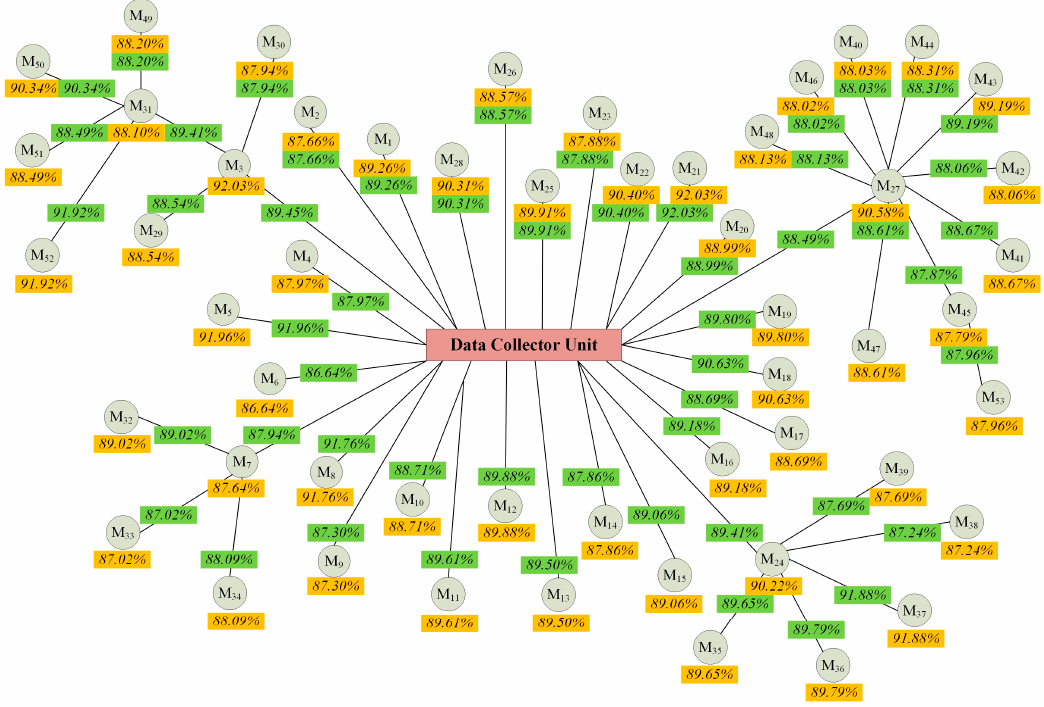
Figure 18. Calculated Average CPIs from Days 1 to 31 for Actual Small-Scale PLC-based AMI.